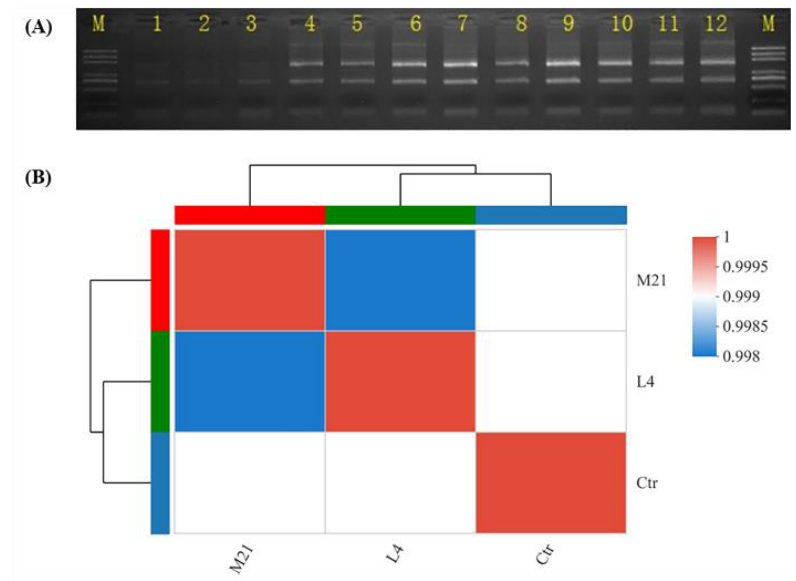
Figure 3. RNA electropherogram ( A ) and sample correlations based on RNA sequencing ( B ). ( A ): M, marker; 1 – 3, EC 50 group; 4 – 6, EC 25 group; 7 – 9, EC 10 group; 10 – 12, control